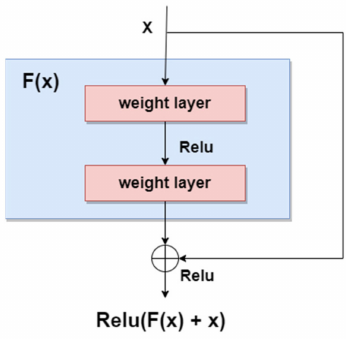
Figure 15. Residual block.